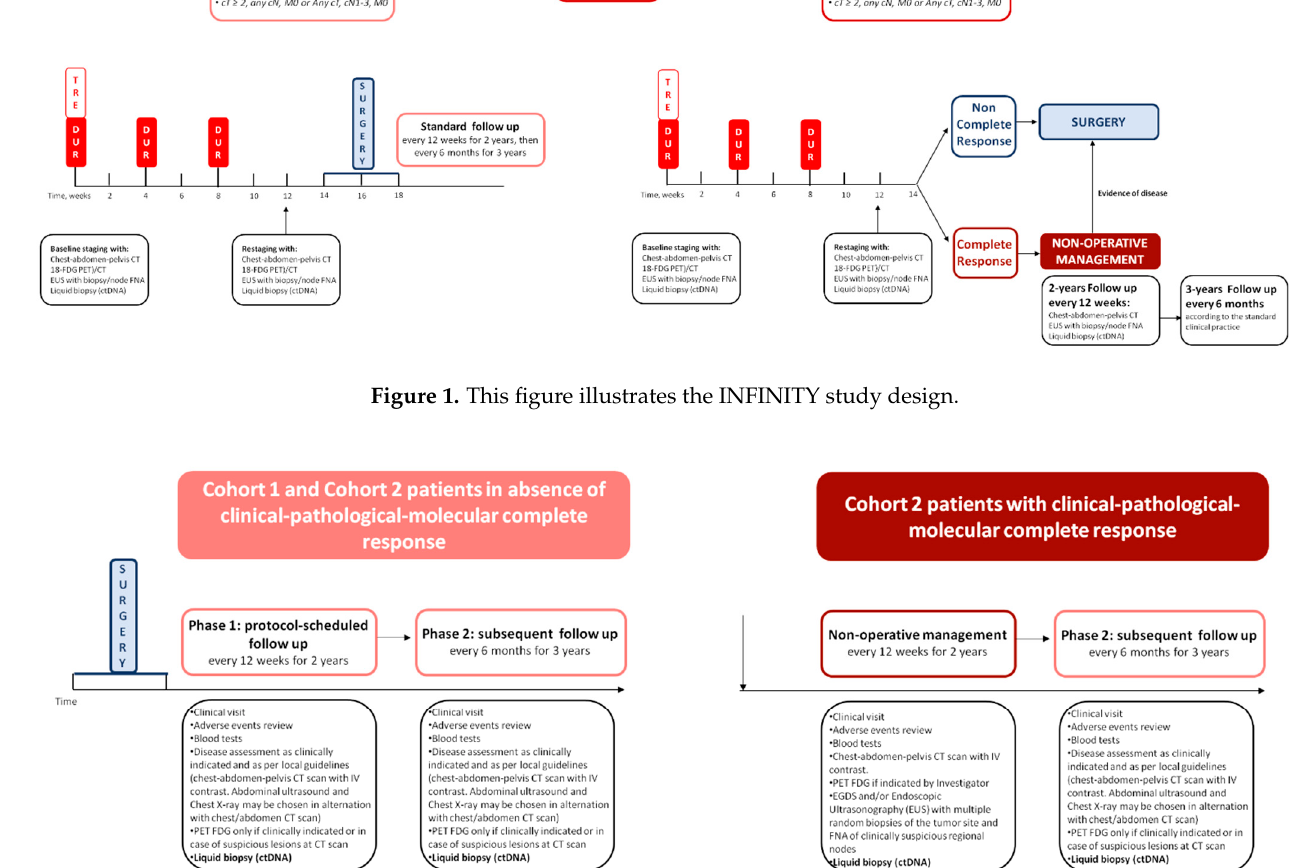
Figure 2. This figure illustrates the follow up phase of the INFINITY study.